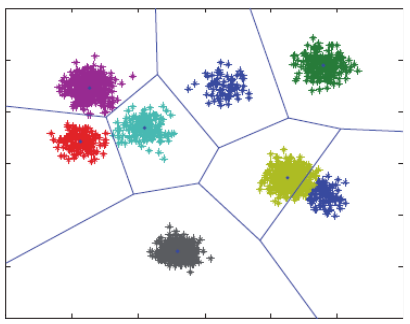
Figure 8. Demonstration of dictionary learning in two dimensional feature space. The colored crosses are the features collected from all the patches in the image. A k -means clustering is performed to get k cluster centers, i.e. the dictionary atoms. Image modified from (Cui,